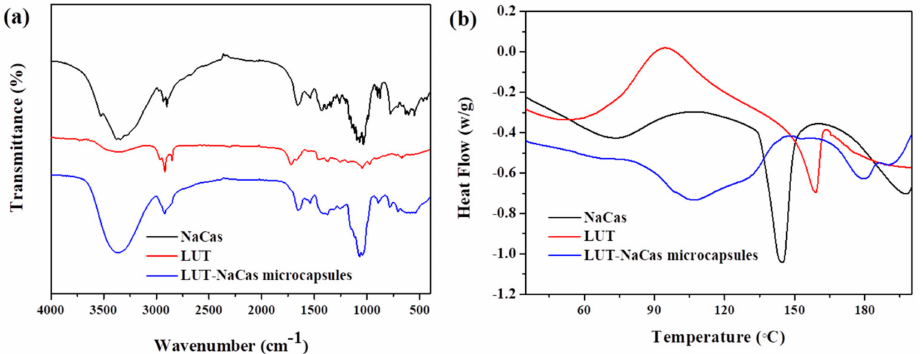
Figure 4. FTIR spectra ( a ) and DSC thermograms ( b ) of the native sodium caseinate (black), lutein crystals (red) and encapsulated lutein (blue).